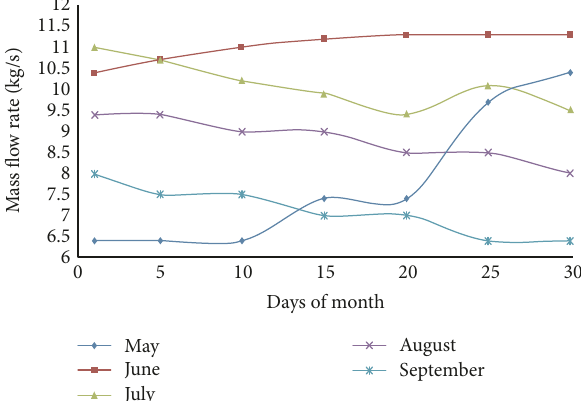
Figure 13: E ffi ciency of the solar fi eld at sunny months.